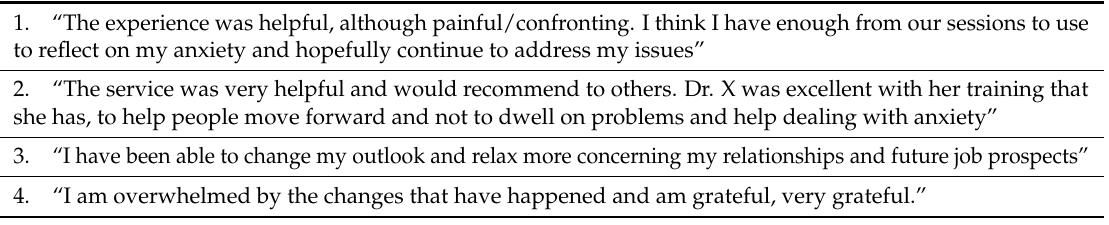
Table 7. Selected Quotes from Patient Satisfaction